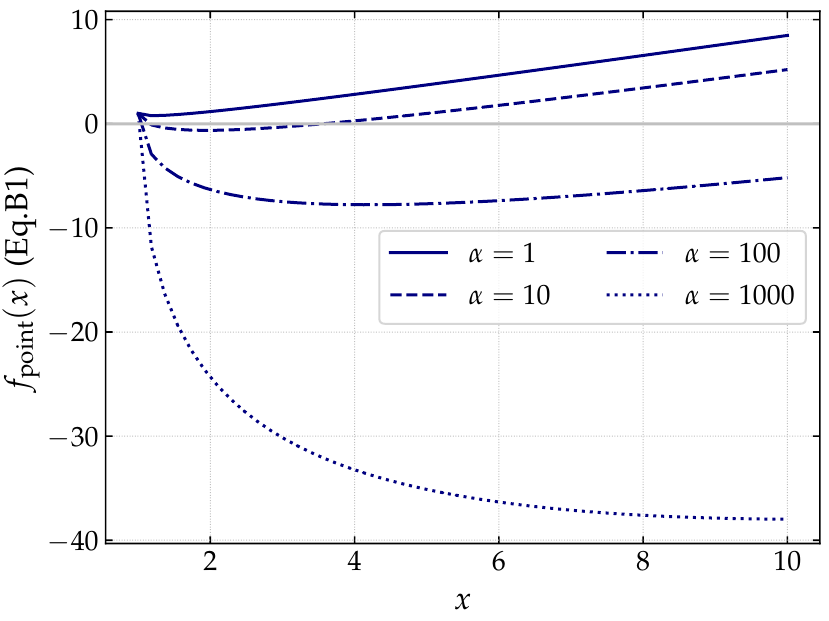
Figure 5 . Function f point given by eq. (B.1) for several values of α